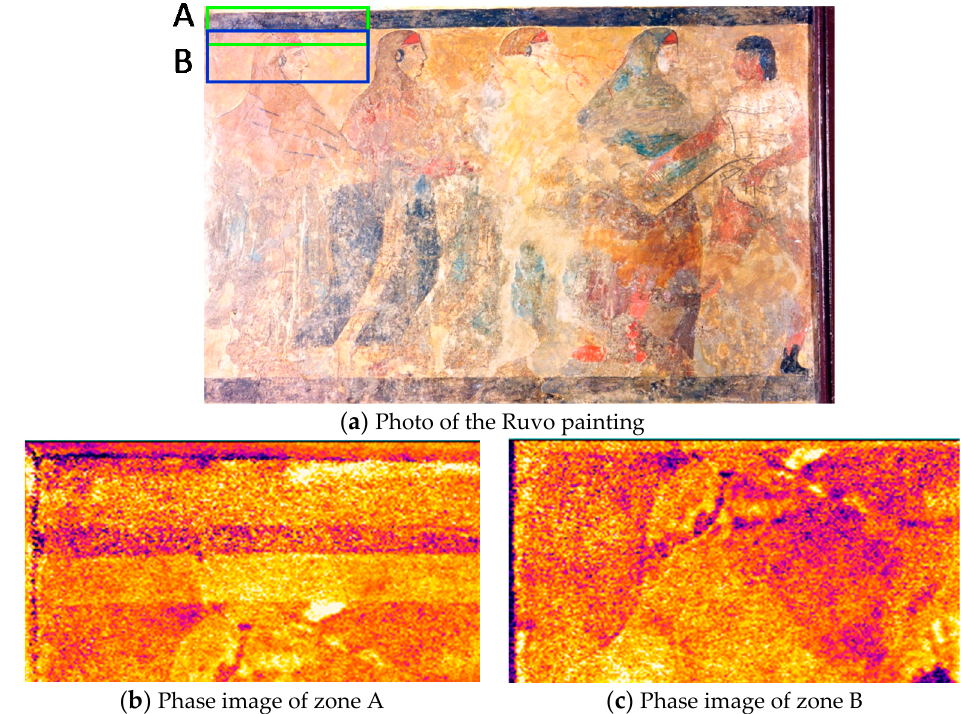
Figure 17. Photo ( a ) and phase images ( b ) and ( c ) taken with an Agema 900 camera.